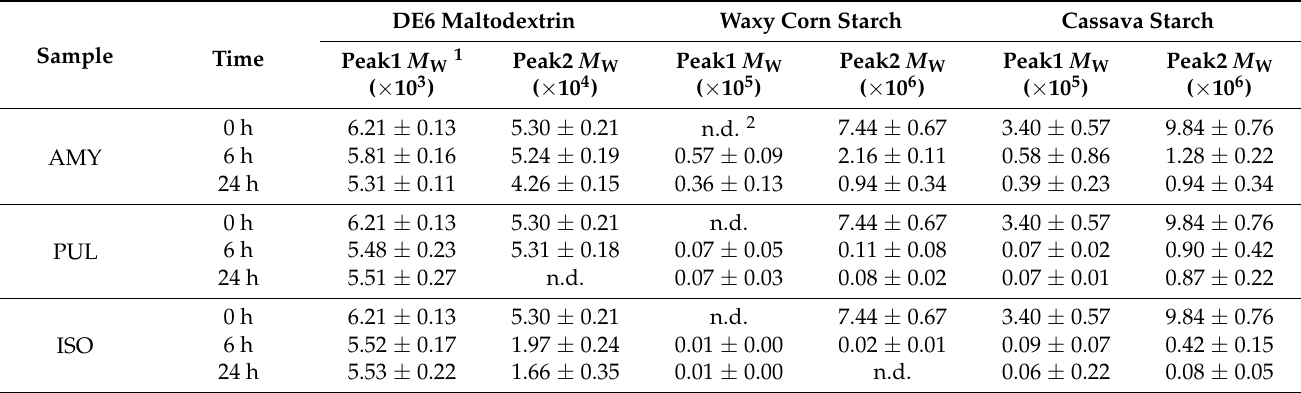
Table 3. Molecular weight distributions of hydrolysates were obtained by debranching DE6 mal- todextrin, waxy corn starch, and cassava starch with AMY, PUL, and ISO, respectively. DE6 Maltodextrin Waxy Corn Starch Cassava Starch Sample